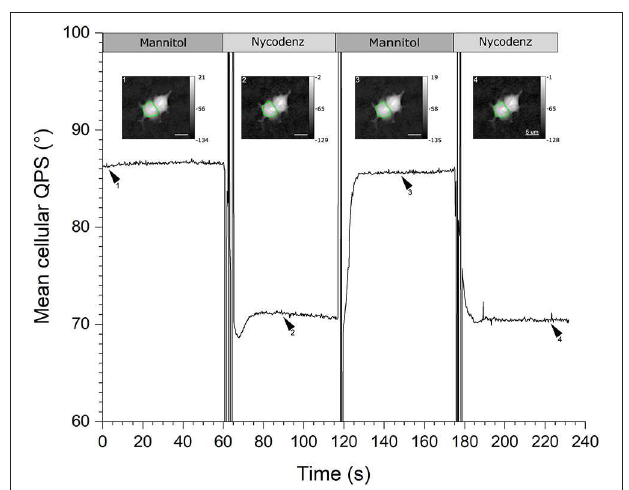
FIGURE 5 | QPS stabilization time. Graph showing the mean cellular QPS of one HEK293T cell during the two-solution decoupling approach. The QPS is averaged over the cell body delineated by the green contour line, shown in the insets. The quantitative-phase images correspond to the time-points as defined by the respective arrowheads. Rectangles across the top illustrate the perfusion sequence of the mannitol- (dark gray) and Nycodenz-based (light gray) solutions. The mean cellular QPS as well as the color bars of the insets are expressed in degrees and the scale bars are 5 µ